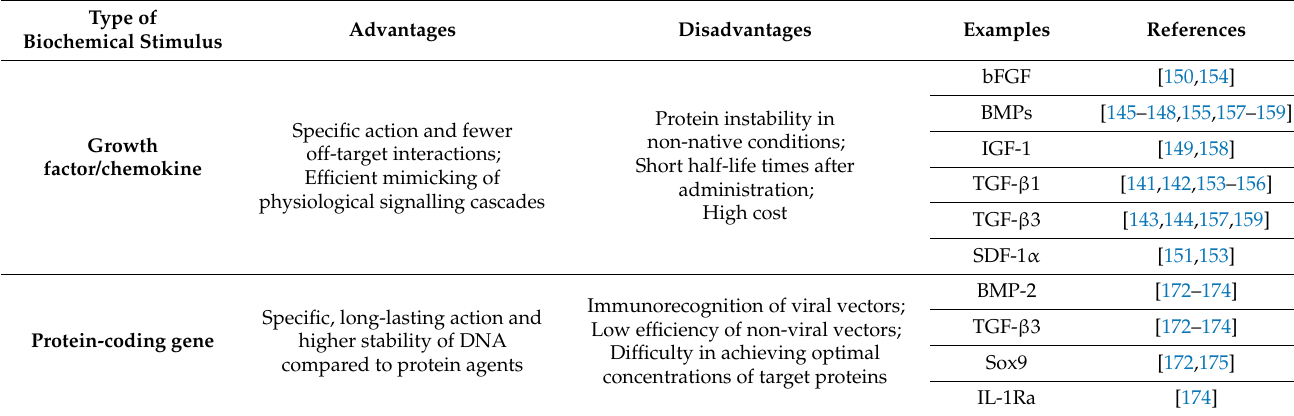
Table 1. Advantages and disadvantages of the use of growth factors, gene delivery, and small molecules as biochemical stimuli in OC